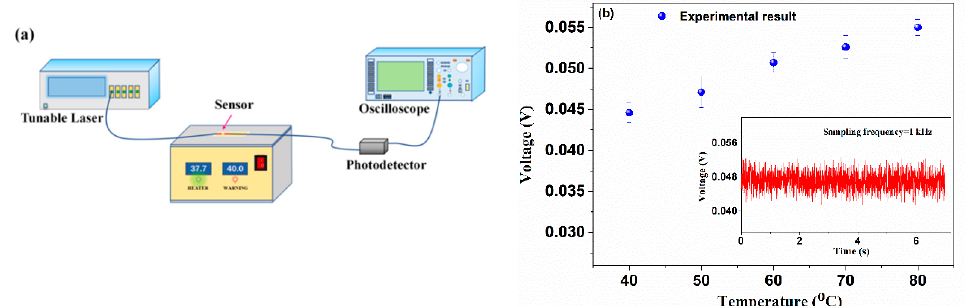
Figure 11. ( a ) Schematic setup for temperature response measurement of the proposed device and ( b ) the temperature response of the device. Inset: transmitted light power in time-domain at a constant temperature of 50 °C.